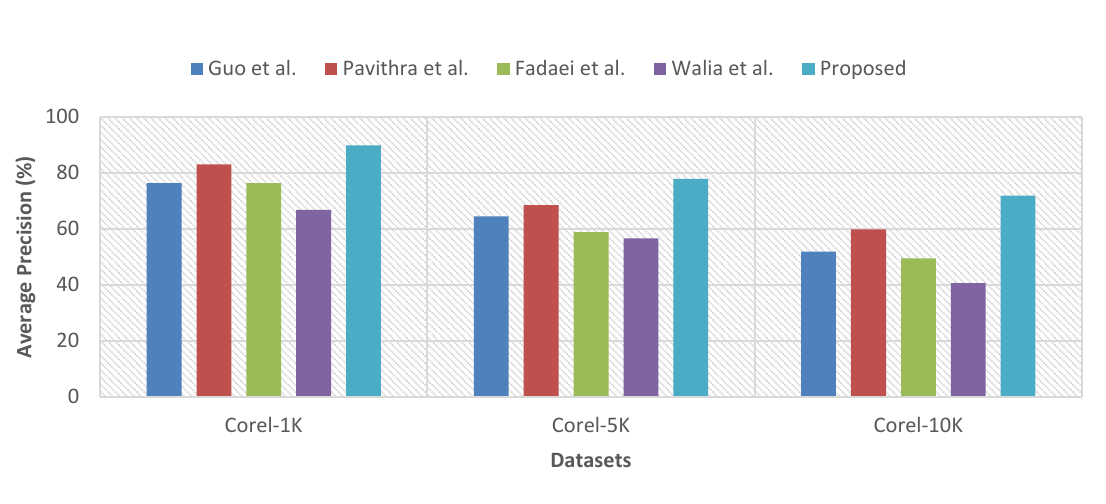
Figure 11 . Performance Comparison of the designed system on different datasets with other techniques